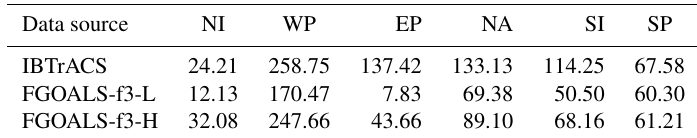
Table 5. Observed and simulated averaged ACE (units: 10 4 kt) in the northern Indian (NI), western Pacific (WP), eastern Pacific (EP), northern Atlantic (NA), southern Indian (SI) and southern Pacific (SP) oceans.